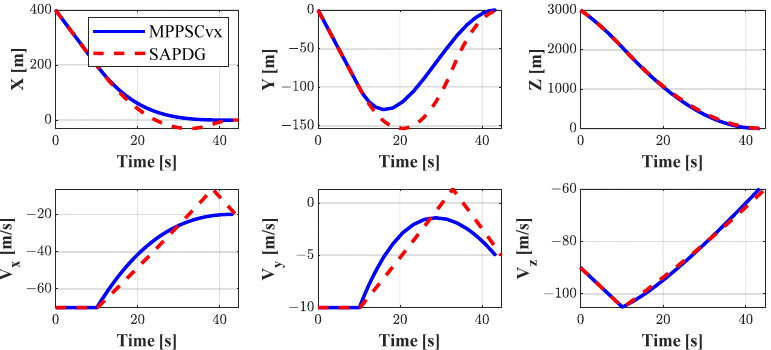
Figure 9. Trajectory comparison of Example 1.